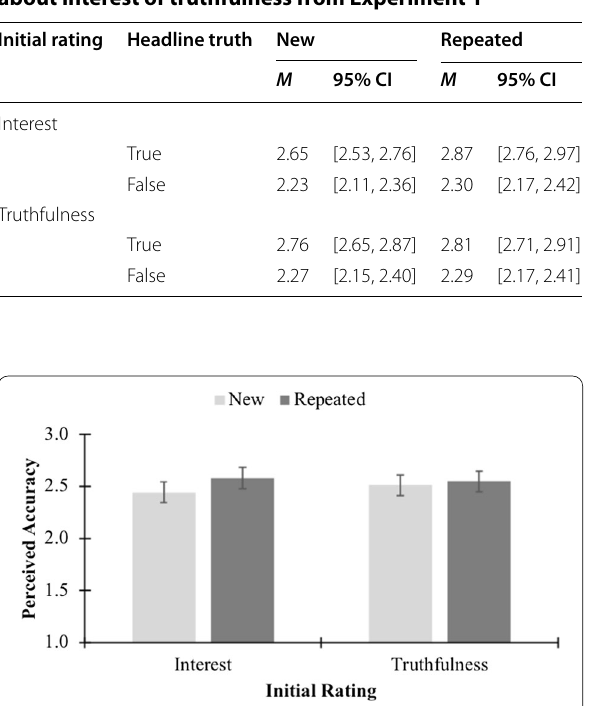
Fig. 2 Differences between perceived accuracy of new and repeated headlines for both initial rating conditions in Experiment 1 (error bars show 95%